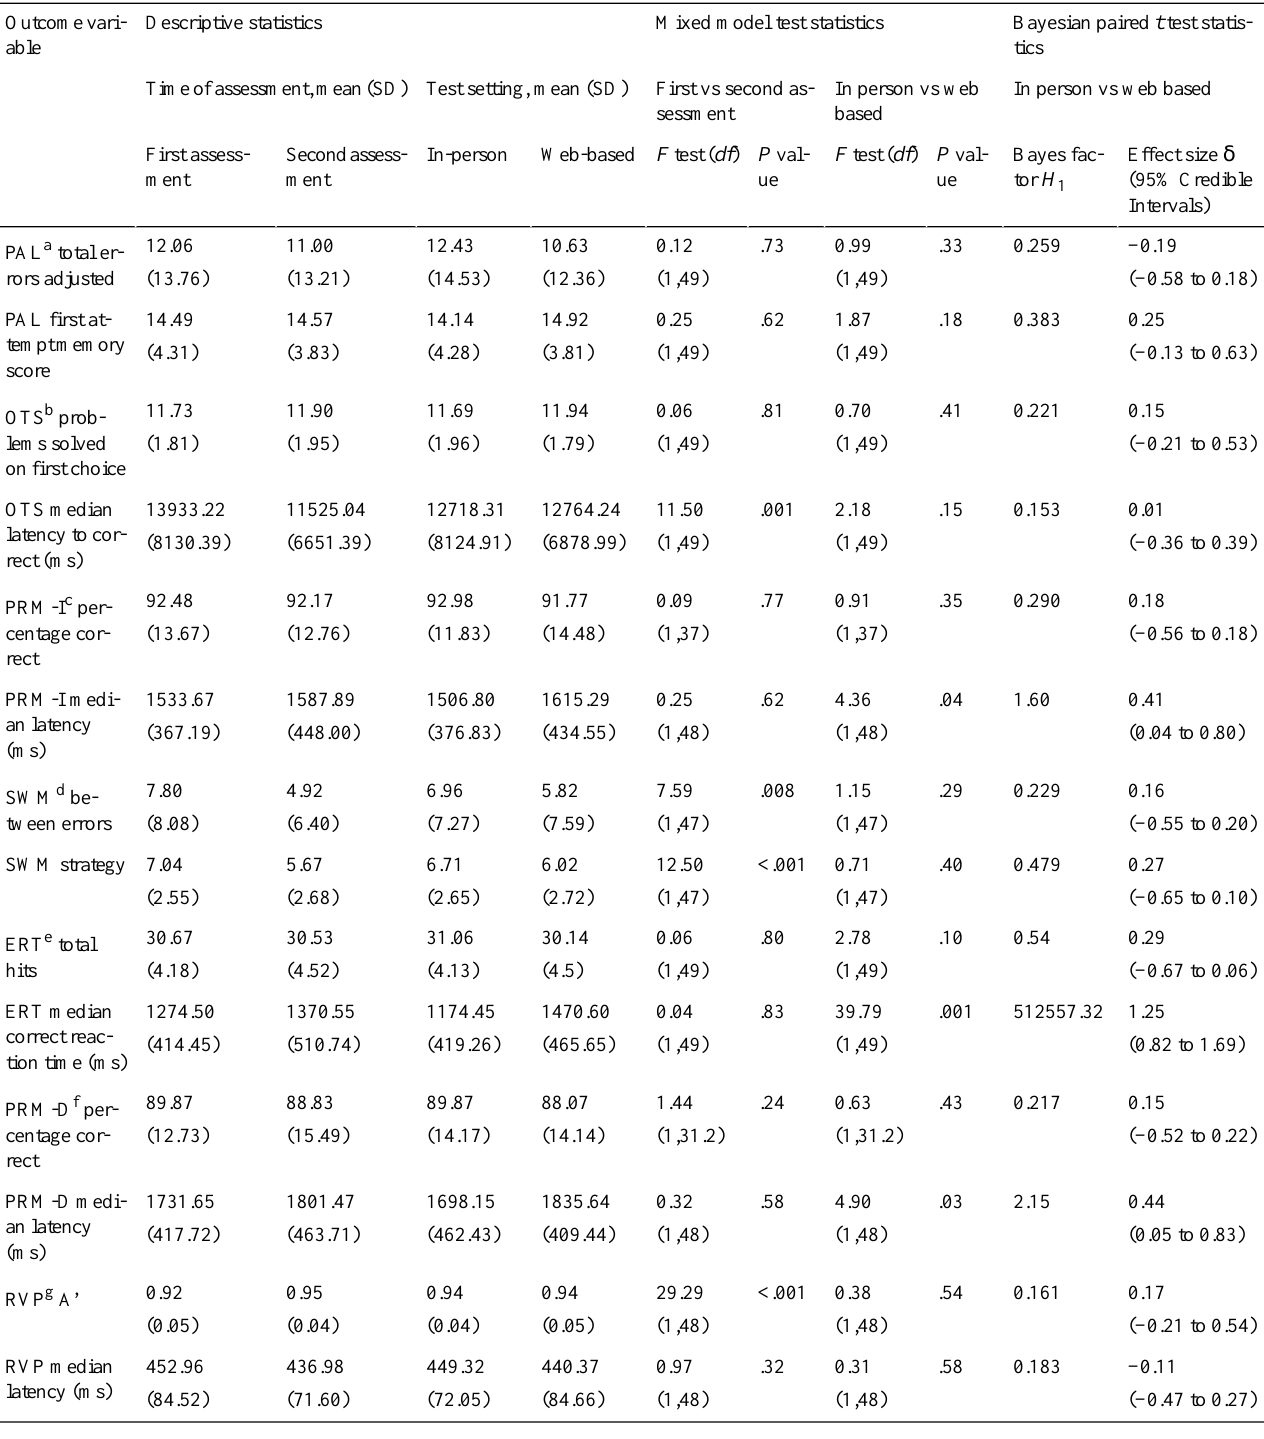
Table 2. Descriptive data for outcome variables and statistical results for equivalence analyses. Time at assessment (first vs second assessment) and test setting (in-person or web-based). Mixed effects model and Bayesian t test